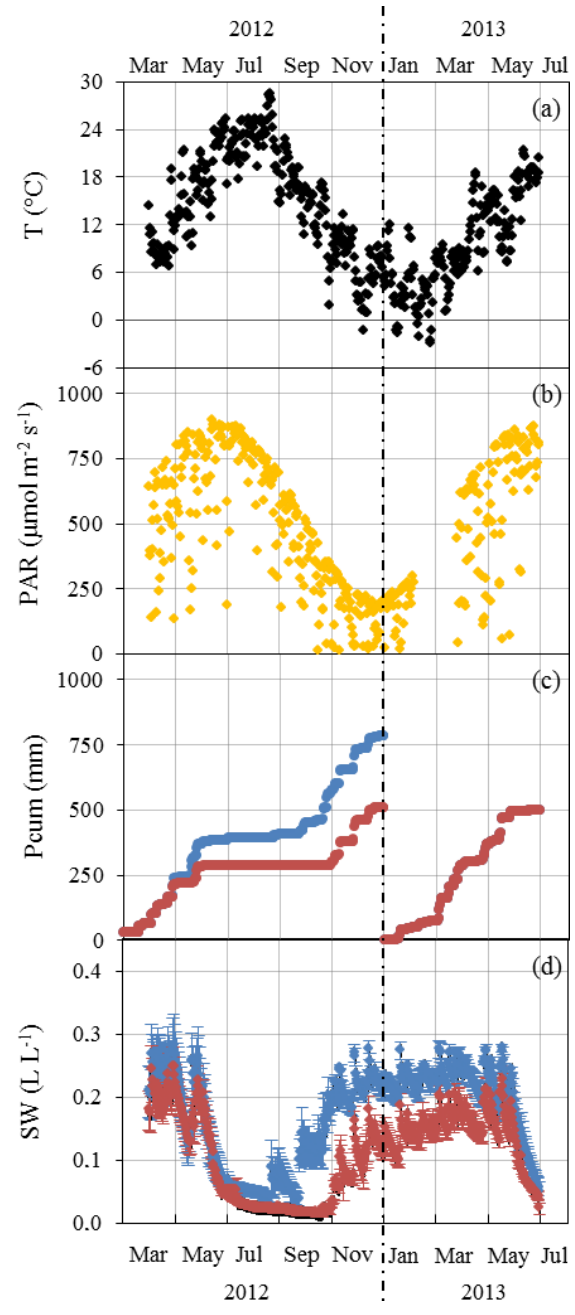
Figure 1. Seasonal variations of daily environmental parameters measured at the O 3 HP from March 2012 to June 2013. (a) Ambient air temperature T was obtained at 6.5m above ground level (a.g.l.), approximatively 1.5m above the canopy. (b) Photosynthetic active radiations PAR received at 6.5ma.g.l. in the ND plot. (c) Cumu- lated precipitation P cum measured over the ND (blue) and AD (red) plot. (d) Mean soil water content SW ± SD measured at − 0 . 1m depth from various soil probes in the ND (blue, n = 3) and AD (red, n = 5)